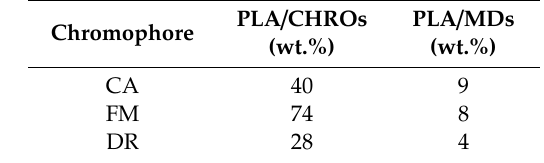
Table 3. Amount 1 of chromophore extracted from PLA mixed with free chromophores (PLA / CHROs) and PLA / MDs.